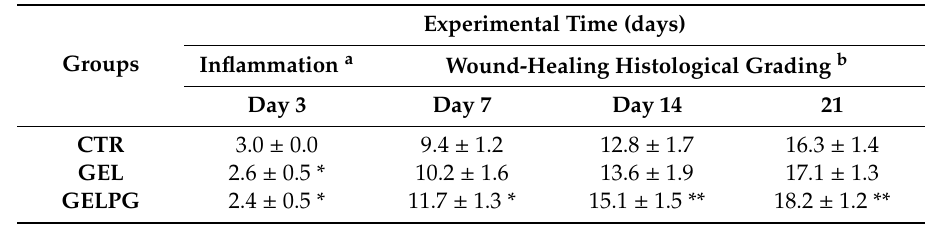
Table 3. Histological assessment of the inflammatory response intensity scores (mean ± standard deviation) over the course of time of the healing of the